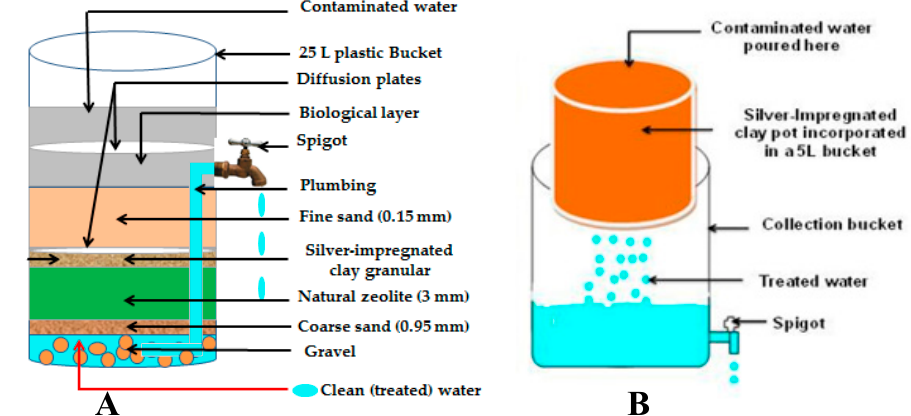
Figure 1. Schematic representation of the Biosand-zeolite silver impregnated clay granular (BSZ-SICG) ( A ) and Silver-impregnated porous pot (SIPP) ( B ) filters showing all layers within the device. Adapted from